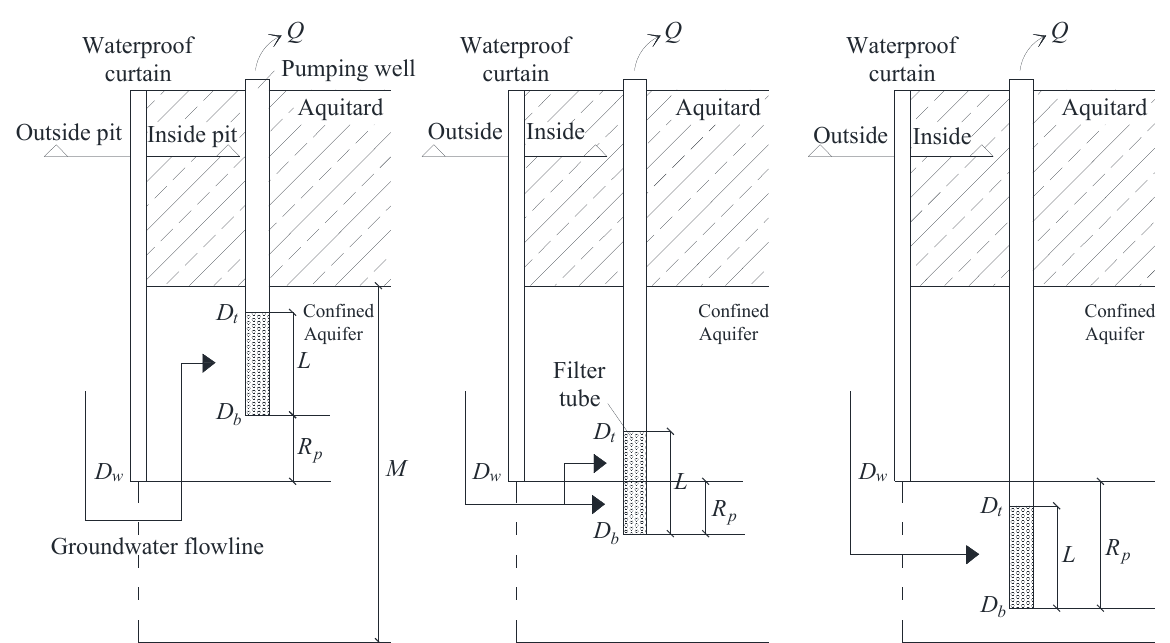
Figure 8. Wall − well patterns of the dewatering inside the foundation pit (recreated by [43,44 ]). ( a ) Figure 8. Wall-well patterns of the dewatering inside the foundation pit (recreated by [43,44]). ( a ) Full-closed pattern; Full − closed pattern; ( b ) Part − closed pattern; ( c ) None − closed pattern. ( b ) Part-closed pattern; ( c ) None-closed